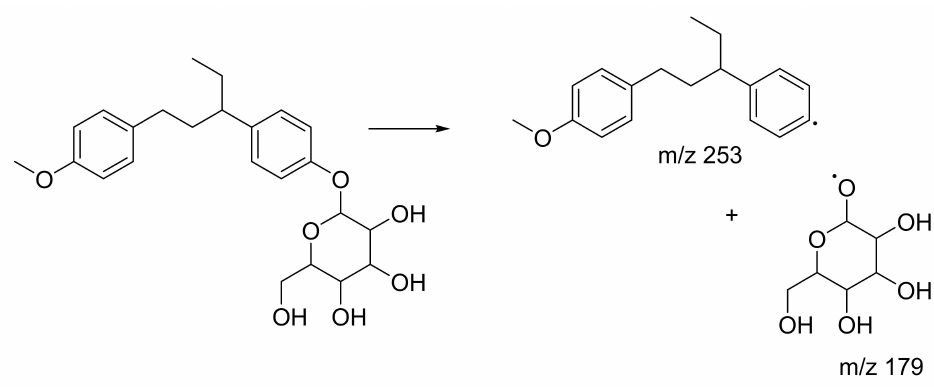
Figure 8. Proposed fragmentation pathway for tetrahydromethylmononyasine A. Peak 7 showed characteristics consistent with ( 2R,4S,5S,6R )-2-ethyl-6-(4-methylphenoxy) oxane-3,4,5-triol, with a parent ion at m / z 267 [M − H] − . The peak appeared at RT 12.20, yielding MS/MS fragment ions at m / z 194. A possible fragmentation pathway for ( 2R,4S,5S,6R )-2-ethyl-6-(4-methylphenoxy)oxane-3,4,5-triol is shown in Figure 9 (Supple- mentary Figure S5). The third highest abundance is peak 12 with RT 15.79 attributed to ( Z )-resveratrol 3,4 (cid:48) -diglucoside. In Figure 10, this metabolite exhibited parent ions at m / z 552 [M − 3H] − and characteristic MS/MS fragment ions at m / z 389 [M − 3H] − and m / z 226, indicating a loss of two glucose compounds from the parent metabolite (Supplemen- tary Figure S6). Metabolites at peaks 7 and 12 have never been identified in C. latifolia and these fragmentation results agree with that of past studies [40,43]. Even though the compounds at peaks 1, 7, and 12 are phenolic glycosides, they were all visualized in three different clusters in the MN. This is because their structures are all slightly different.